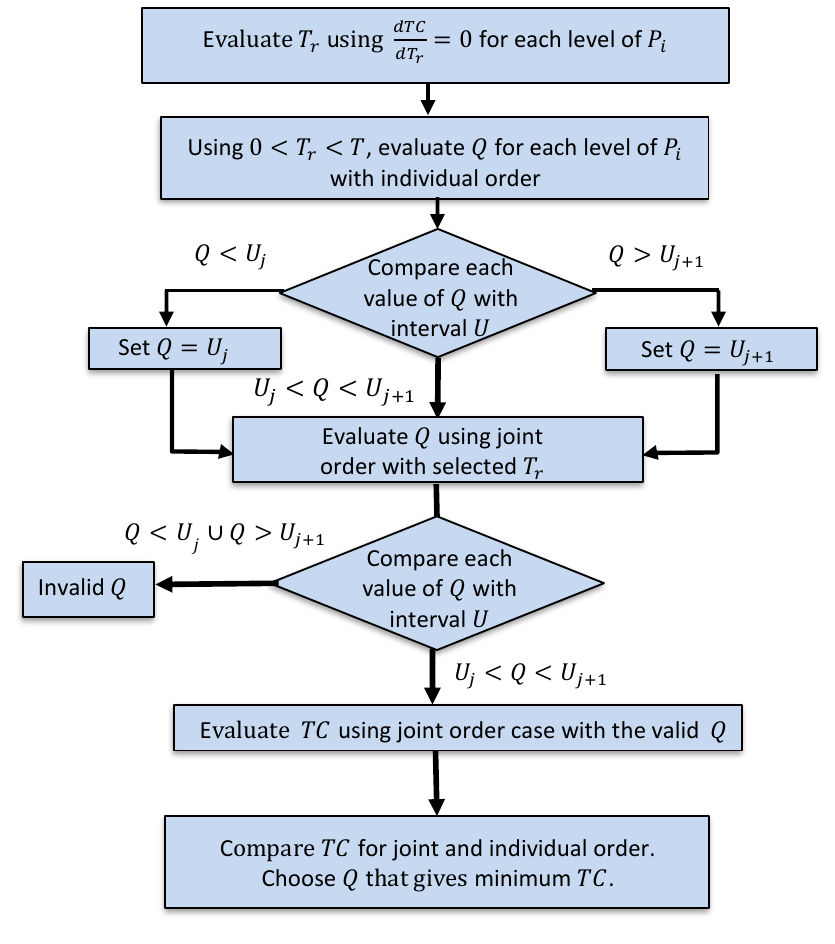
Figure 2. Algorithm to find the optimal